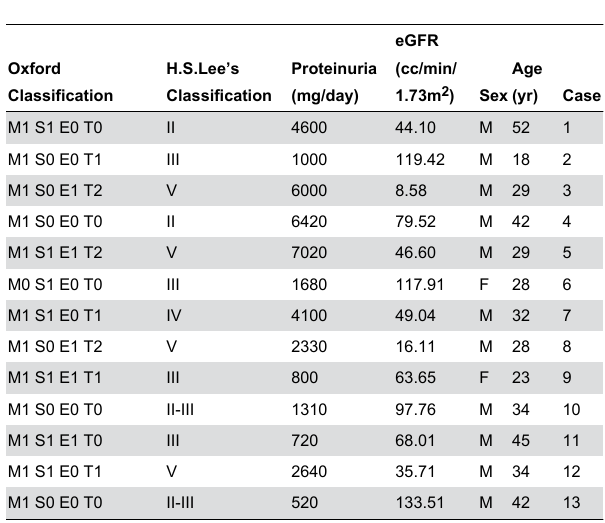
(eGFR: Estimated Glomerular Filtration Rate by CKD-EPI equation; Oxford Classification M: Mesensial hypercellularity, S: Segmental glomerulosclerosis, E: Endocapilary hypercellularity, T: tubular atrophy/ interstitial fibrosis).